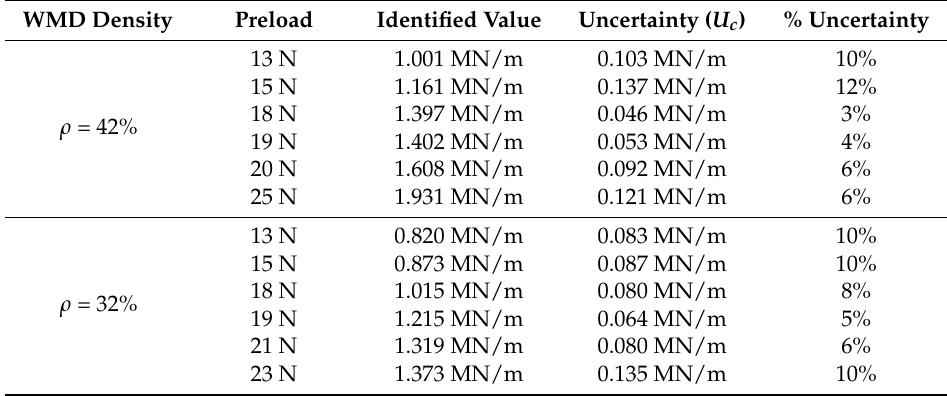
Table A1. Combined standard uncertainty of identified WMD local stiffness ( K Local ) in Figure